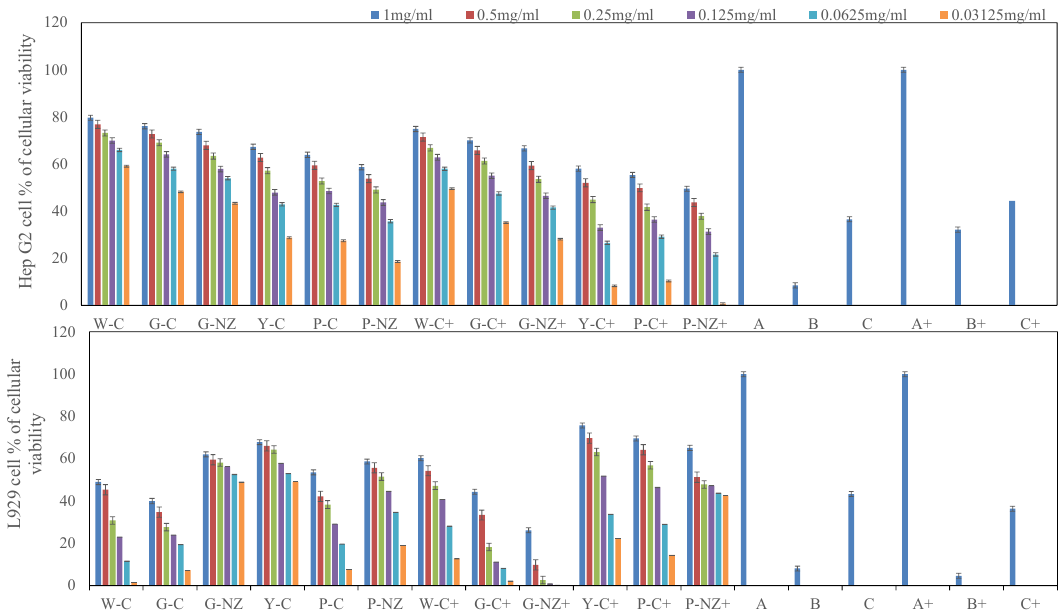
Figure 3. Investigating the bioactive capacity of various concentrations of AR cultivars on the protection of HepG2 and L 929 cells against H 2 O 2 (hydrogen peroxide) exposure during the MTS assay. Data presented as mean ± SEM from three replicates cell culture experiments ( n = 3) from each sample. A Positive control: Cell culture medium; C Negative control: 1% SDS (Sodium dodecyl sulfate) medium; B 0.1% DMSO (Dimethyl sulfoxide) control: 0.1% DMSO + cell culture medium. A+ Positive control+: cell culture medium+H 2 O 2 (500 mM); C+ Negative control+: %SDS +H 2 O 2 (500 mM); B+ 0.1% DMSO control+: 0.1% DMSO+ cell culture medium+H 2 O 2 (500